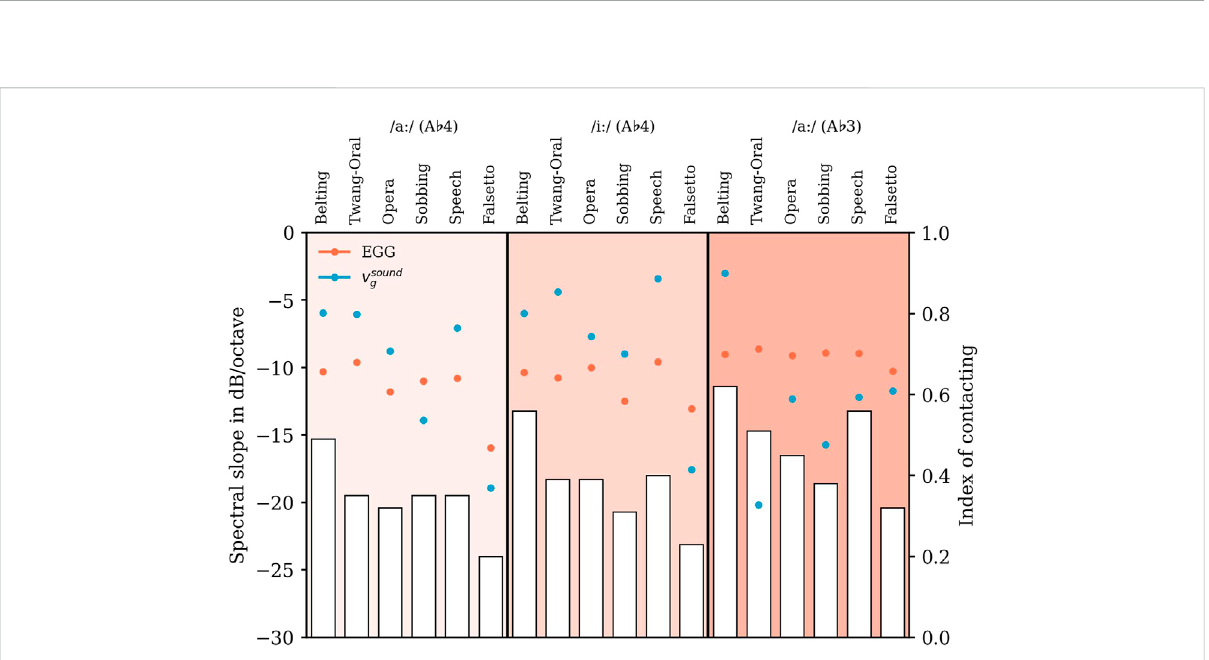
FIGURE 8 SlopesindB/octave(leftordinate)oftheexperimentallyderivedEGG-spectra(circles, fi lledinorange)andthecomputedparticlevelocity v sound g attheglottis (circles, fi lled inblue).Thesequantities areshownfor allvoice qualities, vowels,and pitchvalues (seeabscissa).Additionally,theIndexof contacting I c ,limitedbyzeroandone(correspondingtotherightordinate),ishighlightedwithwhitebars.Theresultsfortwovowels(/a ː /and/i ː /)and the pitch values are fi lled separately with different shades of